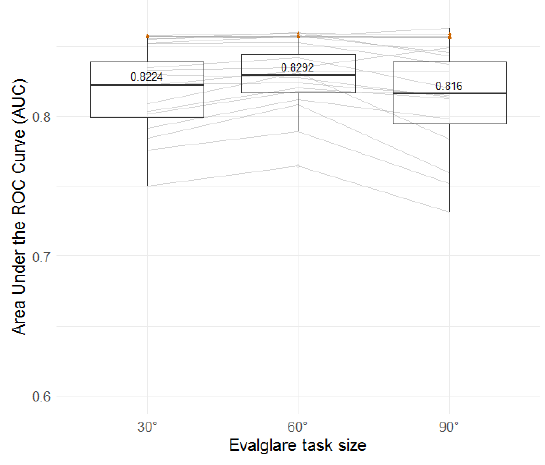
Figure 27. Boxplots of AUC for the three task area sizes (laboratory study).